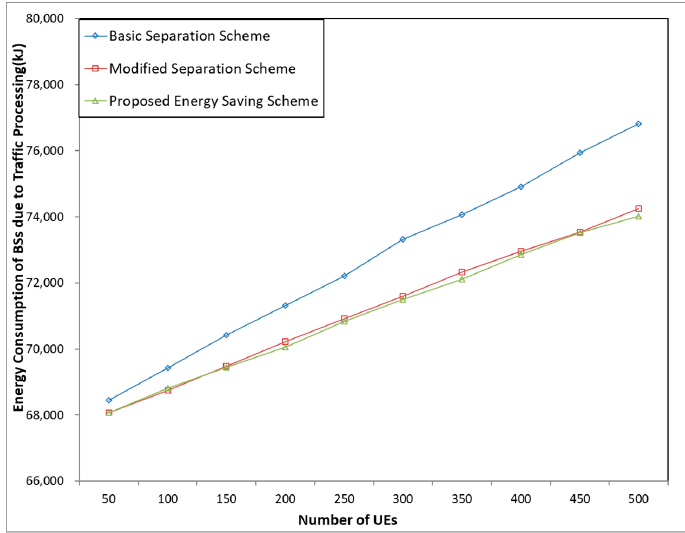
Figure 9. Energy consumption of BSs due to traffic processing.